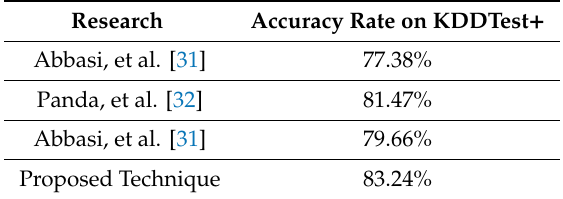
Table 17. Accuracy comparison of the proposed model on NSL-KDD (Test +